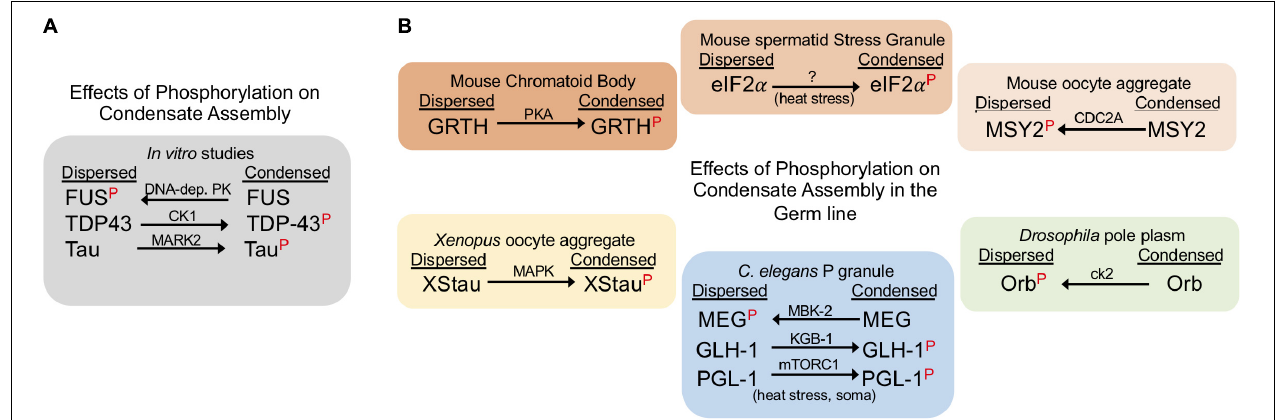
FIGURE 2 | Phosphorylation can suppress or promote condensate assembly. The red P indicates the phosphorylated form of the corresponding protein. Arrows indicate whether phosphorylation drives a dispersed or condensed state; kinase names are above each arrow. (A) Phosphorylation has varying effects on phase separation in in vitro studies. (B) Phosphorylation negatively and positively regulates RNP condensates in the germ line. The effects of phosphorylation are shown for proteins in six distinct germ line RNP granules in three model systems. Note: phosphorylation of the C. elegans P granule protein PGL-1 during heat stress conditions promotes condensates in somatic cells, outside of the